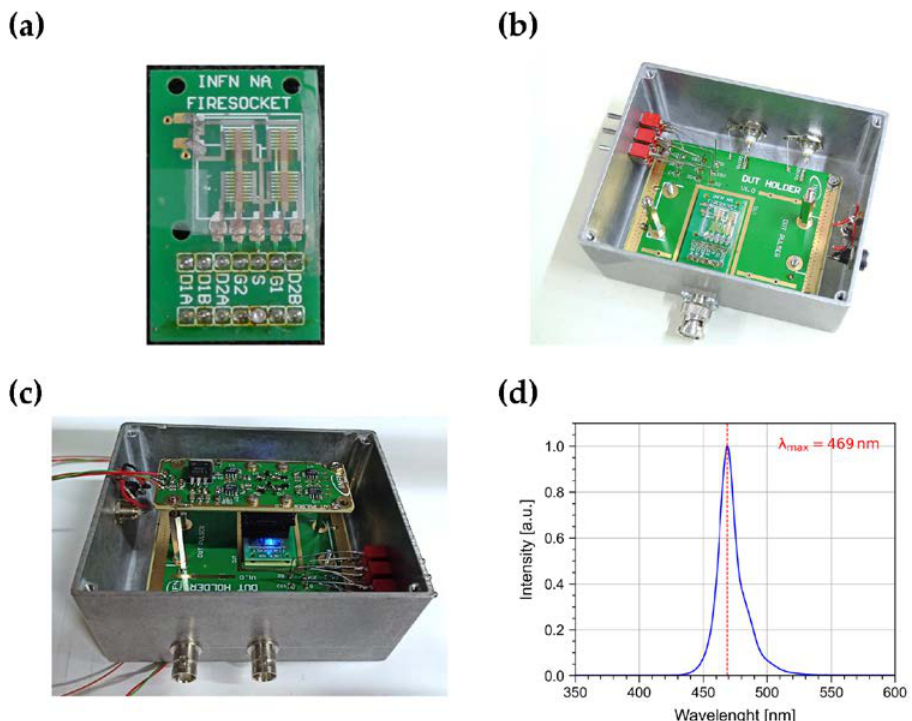
Figure 1. Pictures of ( a ) the 2 × 2 OPT matrix bonded on a custom-made socket; ( b ) the OPT matrix on the socket arranged on a motherboard within an aluminum box used as Faraday cage; ( c ) the aforementioned setup with a LED source and its driver circuit mounted on top of the OPT. ( d ) Emission spectrum of the LED source.